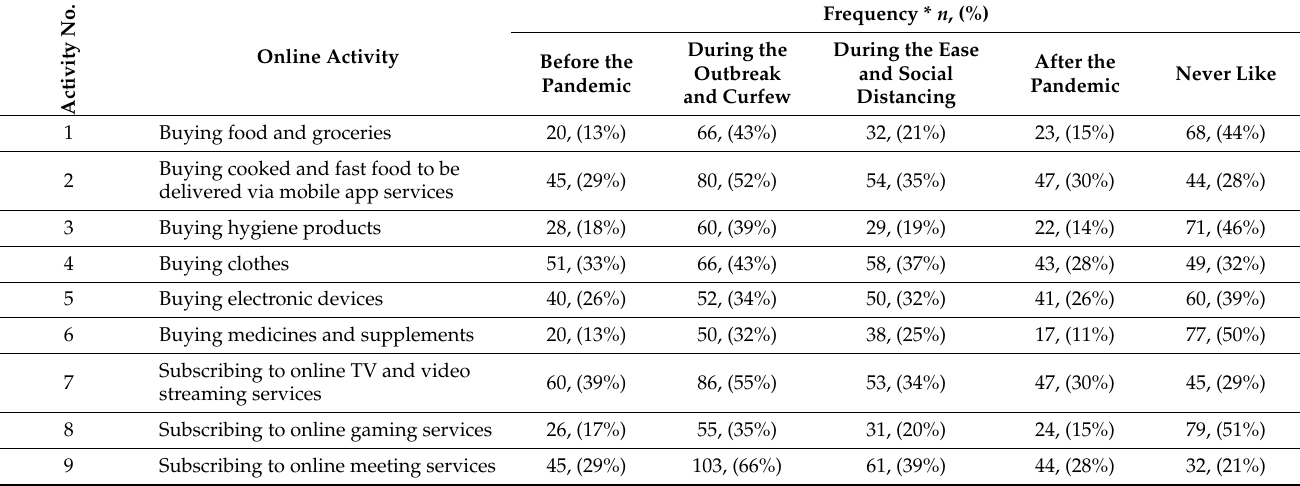
Table 4. The intention of utilizing e-commerce and e-services ( n =